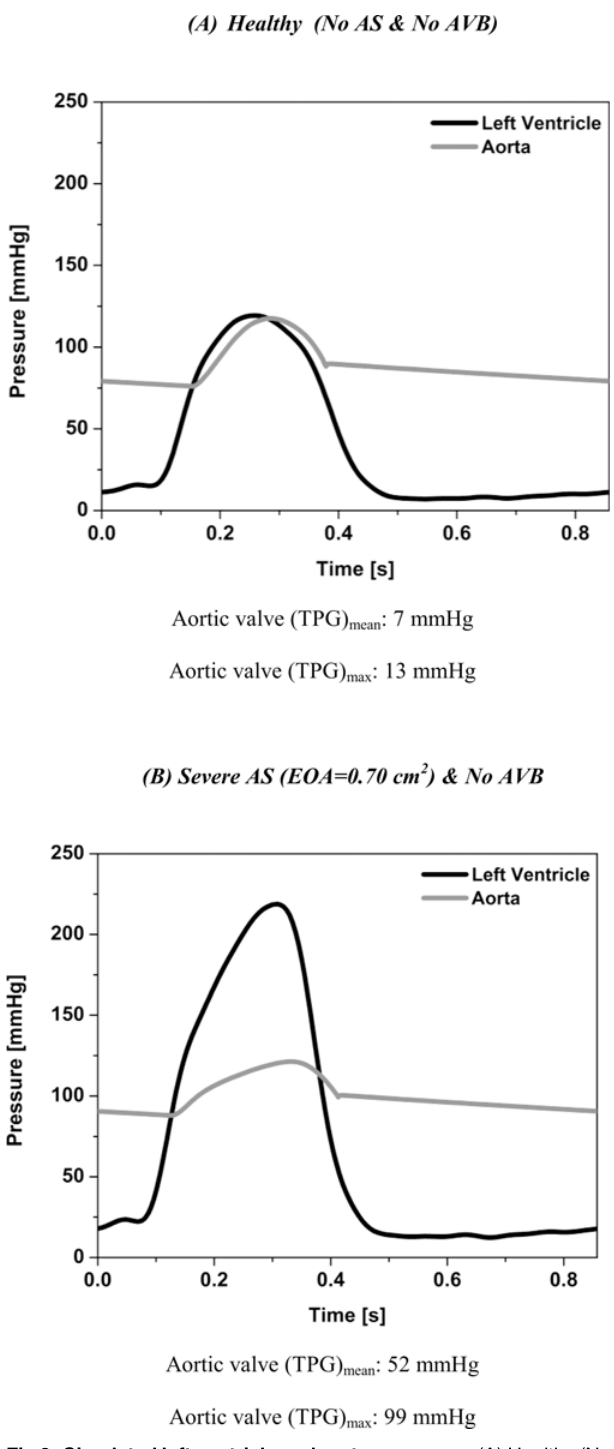
Fig 2. Simulated left ventricle and aorta pressures. (A) Healthy (No AS & No AVB), (B) severe AS (EOA = 0.7 cm 2 ) & No AVB. Stroke volume, heart rate and cardiac output are 75 ml, 70 beats/min and 5.2 l/ min,